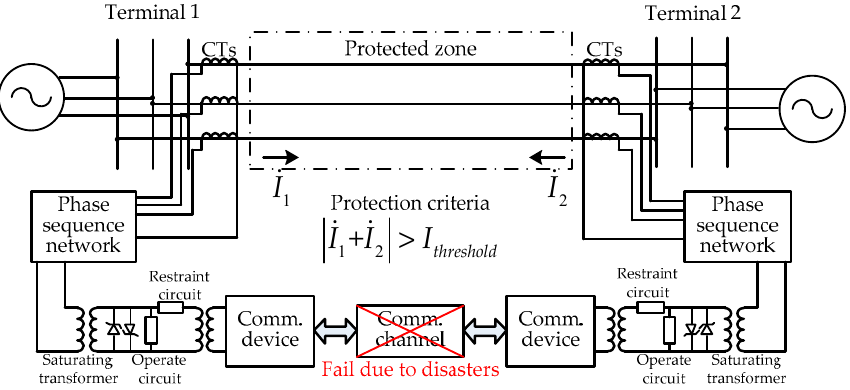
Figure 1. Functional setup of current differential protection.